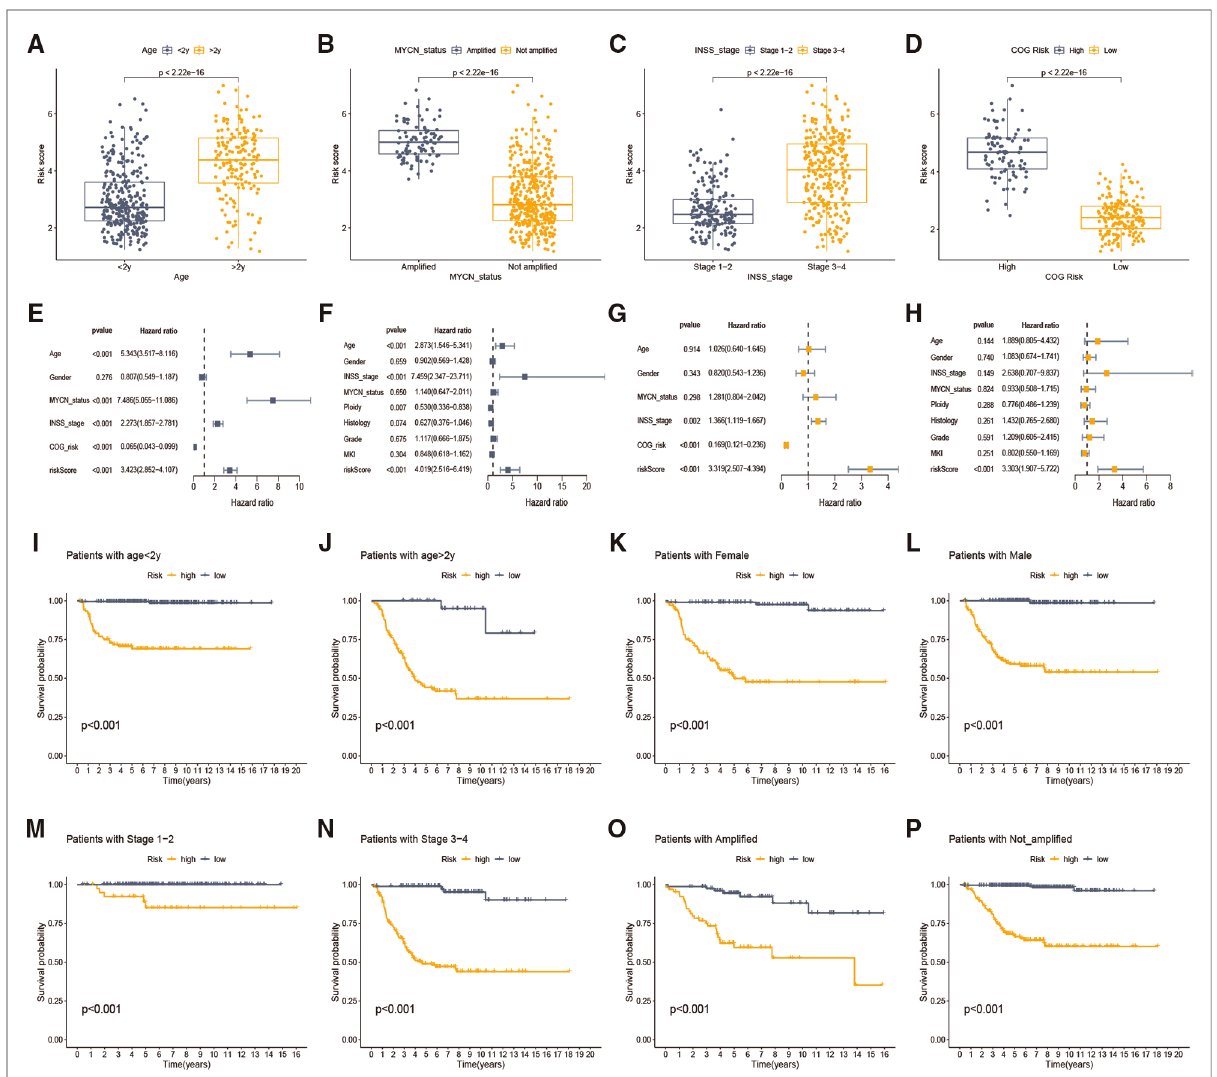
FIGURE 3 Clinical signi fi cance of the cuproptosis-related signature. ( A – D ) The association between clinical traits and CRG-score of NB. ( E,F ) Forest plot of univariable Cox model for survival in the training ( E ) and testing sets ( F ). ( G,H ) Independent prognostic value of CRG-score by multivariate analysis in the training ( G ) and testing sets ( H ). ( I – P ) The prognostic role of the CRG-score was studied in different variable